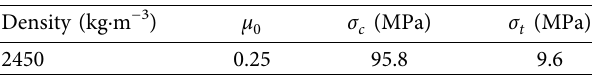
Table 2: Physical and mechanical properties of rock mass.